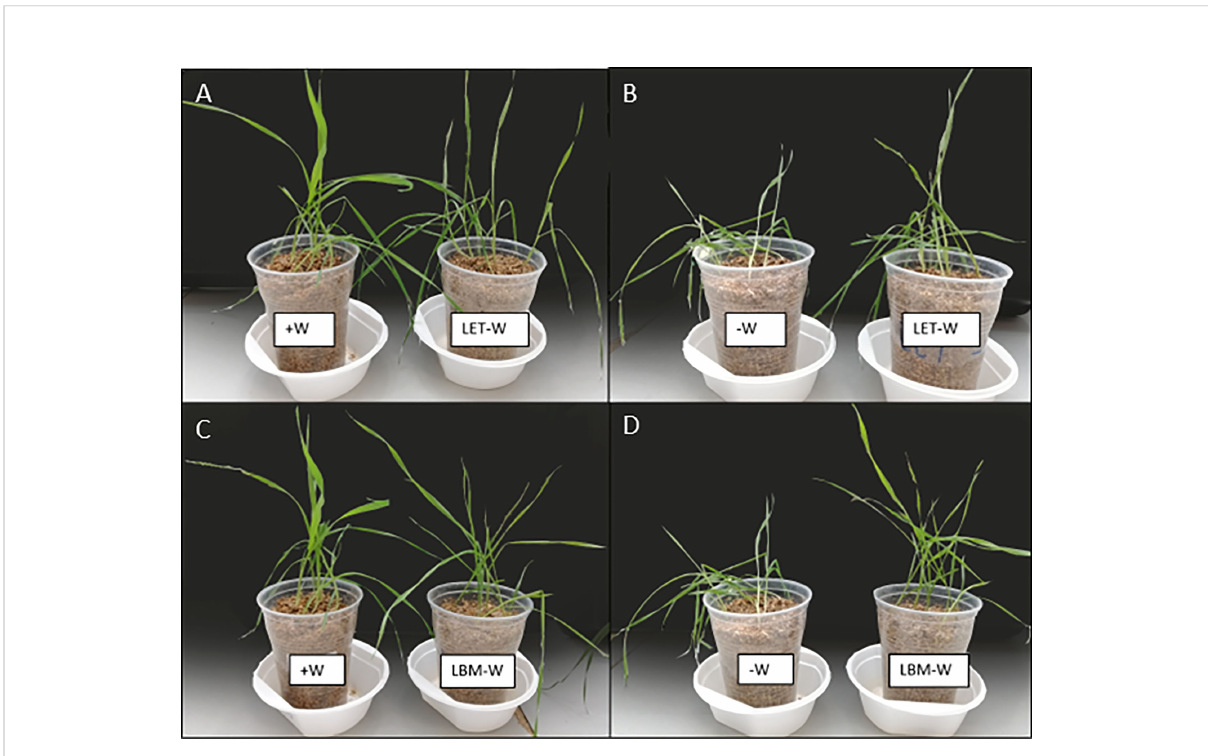
FIGURE 1 Effect of rhizobia strains LET and LBM inoculations on wheat plants under water-stress conditions compared to non-stressed wheat plants (A, C) and water-stressed wheat plants without rhizobia inoculations (B, D)